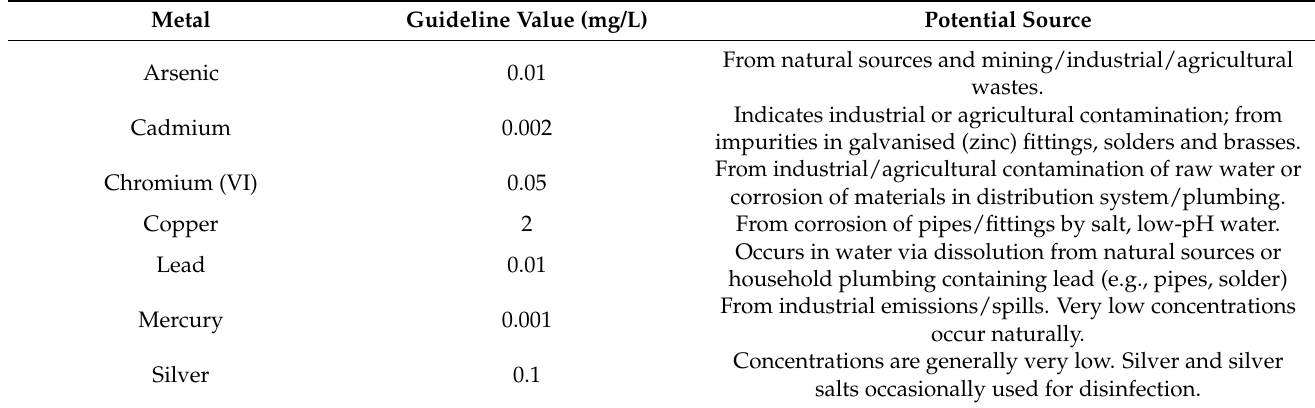
Table 2. Australian Drinking Water Guidelines for Selected Metals